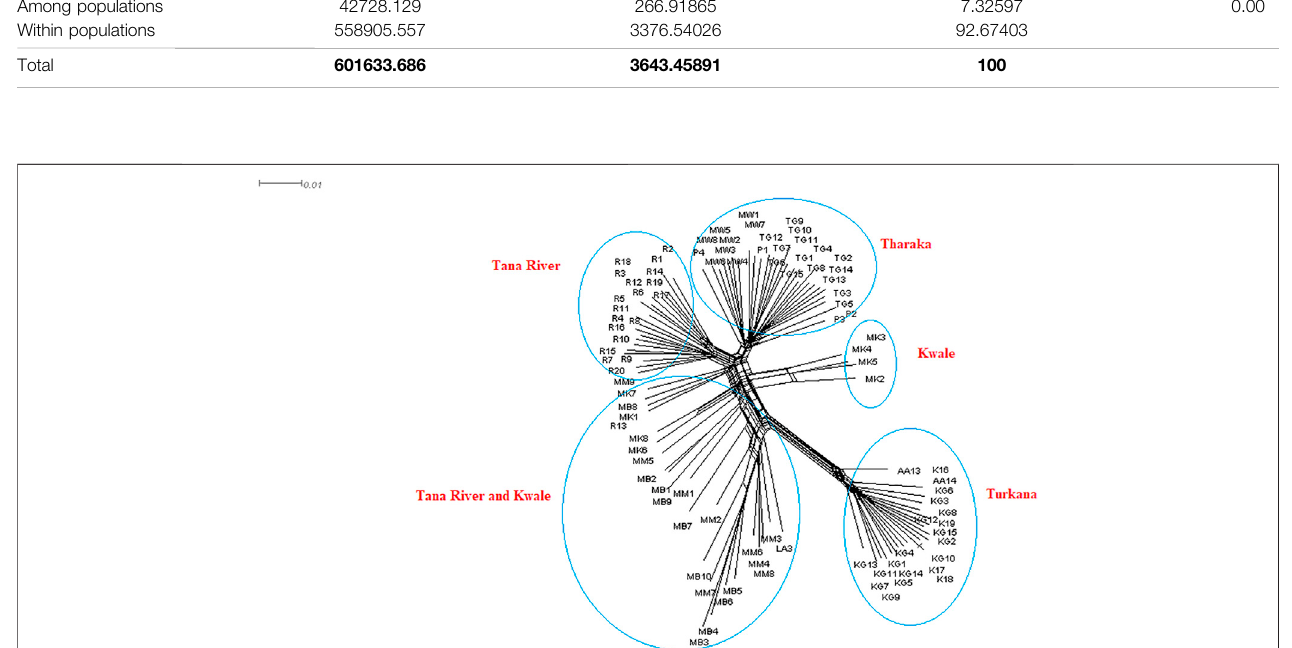
TABLE 4 | Analysis of molecular variance (AMOVA) in genetic variation of Hyphaene compressa among and within populations of Kwale, Tharaka, Turkana and Tana River counties in Kenya. Source of variation Sum of